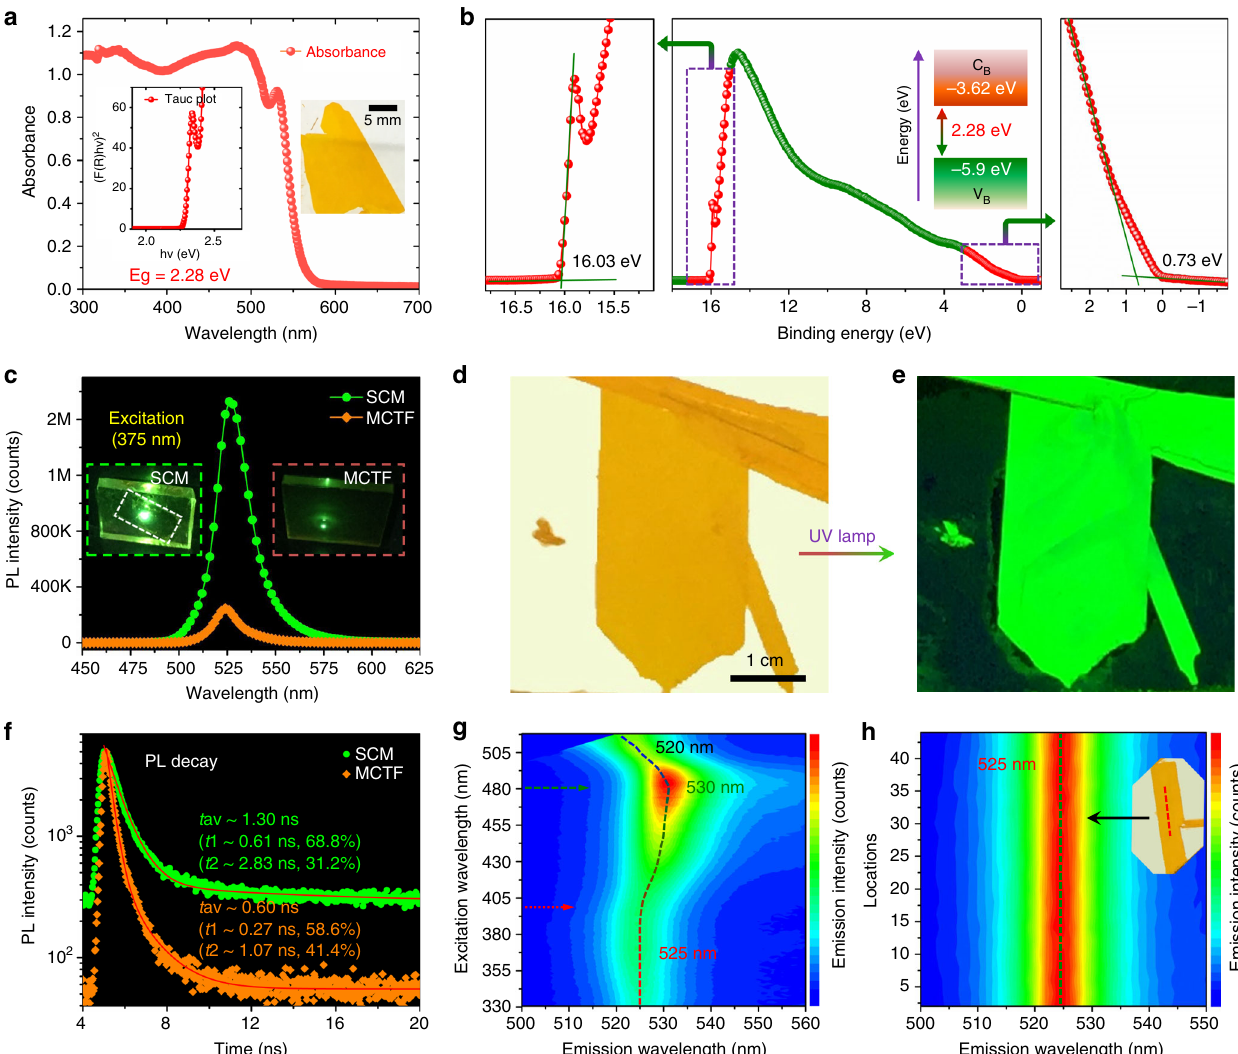
Fig. 5 Optical properties of (PEA) 2 PbI 4 SCM. a The absorbance spectrum and corresponding Tauc plot of the (PEA) 2 PbI 4 SCM showing a band gap 2.27 eV. The inset shows the photograph of the (PEA) 2 PbI 4 SCM used for absorbance measurement. b Ultraviolet photoemission spectroscopy (UPS) of the (PEA) 2 PbI 4 SCM. Insets: energy band diagram for the (PEA) 2 PbI 4 SCM. c Photoluminescence spectrum of the (PEA) 2 PbI 4 SCM and MCTF excited at 375 nm. Inset: the photo of the (PEA) 2 PbI 4 SCM and MCTF excited at 375 nm. d , e Photographs of the (PEA) 2 PbI 4 SCM under weak room light and strong UV lamp. f Time-resolved PL of the (PEA) 2 PbI 4 SCM and MCTF at 525 nm. The excitation laser beam wavelength is 375 nm. Inset: Photograph of the green photoluminescence of a (PEA) 2 PbI 4 SCM (left) and MCTF (right) excited by a 375 nm laser beam. g 3D excitation – emission plot for the (PEA) 2 PbI 4 SCM. Emission intensity rises with the color changing from blue to green and red. h Evolution of the photoluminescence spectrum shown using pseudocolor plot, indicating consistent emission peak wavelength and intensity across the large